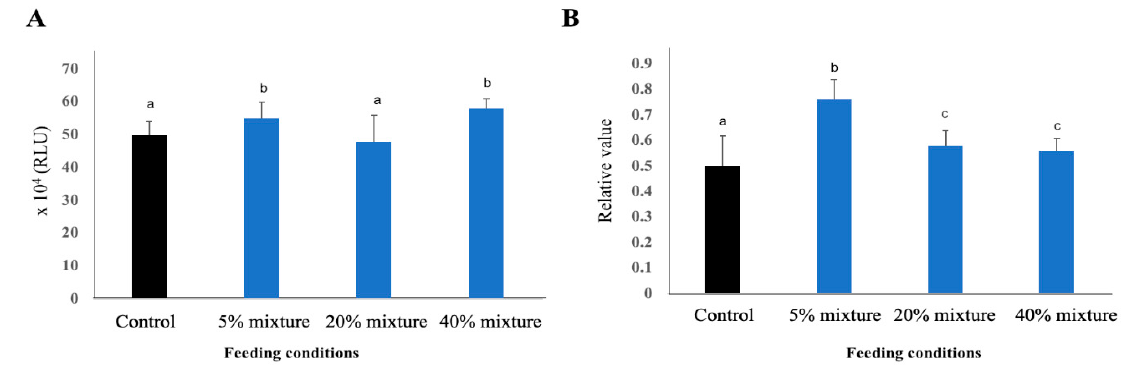
Figure 6. Phagocytic activity ( A ) and complement activity ( B ) in the blood of study pigs at 17 weeks of their age. Results presented are the mean ± SD of three independent experiments. Different letters upon the bars indicate significant difference at 5% ( p < 0.05) while same letters indicate no significance difference when compared two bars.